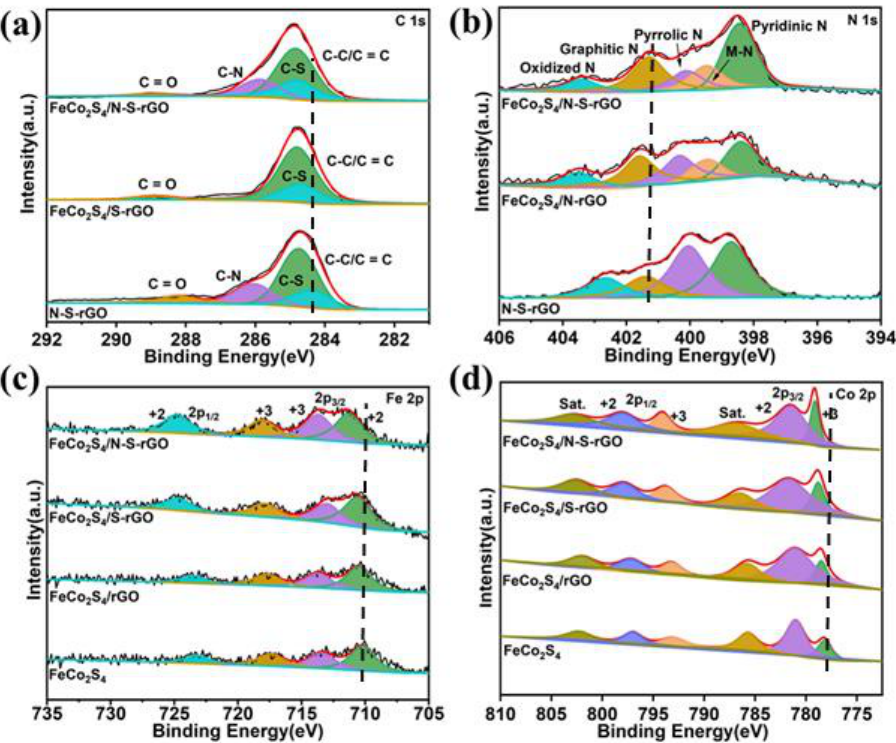
Figure 2. ( a ) Fine XPS patterns of C 1s of different catalysts; ( b ) fine XPS patterns of N 1s; ( c ) fine XPS patterns of Fe 2p; ( d ) fine XPS patterns of Co 2p.